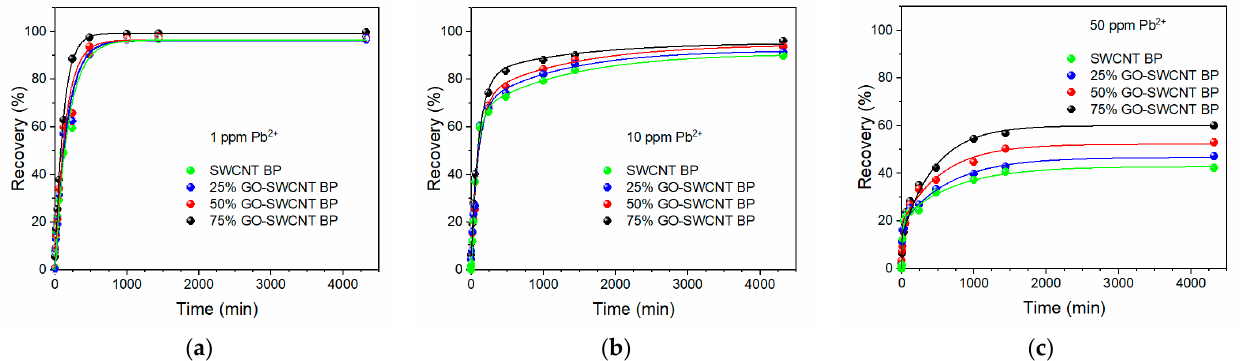
Figure 4. Pb 2+ recovery by neat SWCNT BP and GO-SWCNT BPs during soaking in 800 mL of aqueous solutions with [Pb 2+ ] of: ( a ) 1 ppm, ( b ) 10 ppm, and ( c ) 50 ppm.